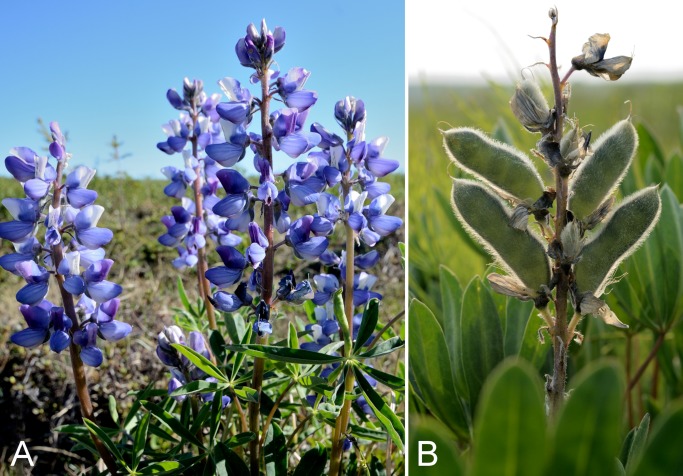
Lupinus arcticus.(A) Inflorescence, Saarela et al. 3125. (B) Fruits, Kugluk (Bloody Falls) Territorial Park, Nunavut, 13 July 2014. Photographs by R. D. Bull.